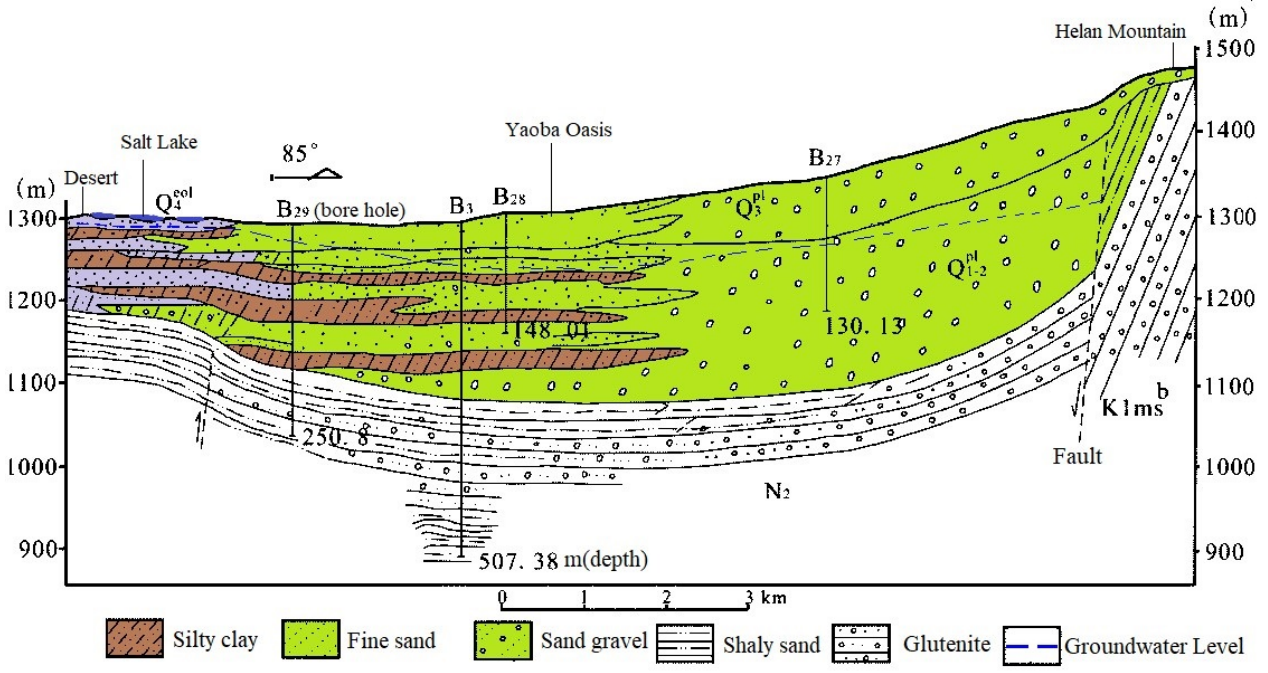
Figure 2. Hydrogeological profile of Yaoba